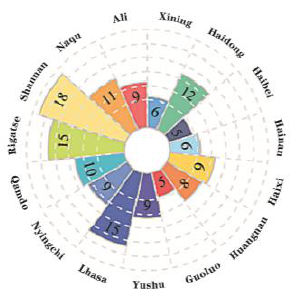
Figure 8. High-quality tourism resources in the cities of the Tibetan Plateau.